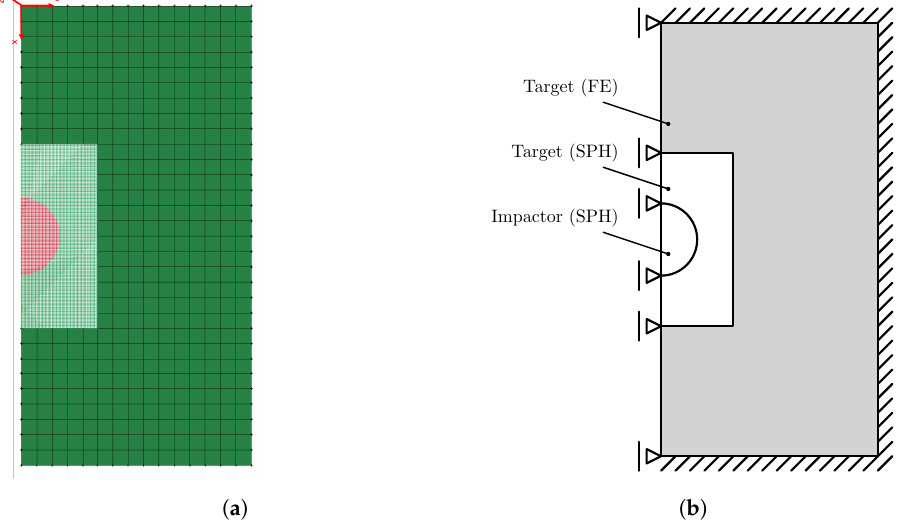
Figure 5. Simulation set-up showing ( a ) FE mesh, SPH regions and coordinate system; and ( b ) bound- ary